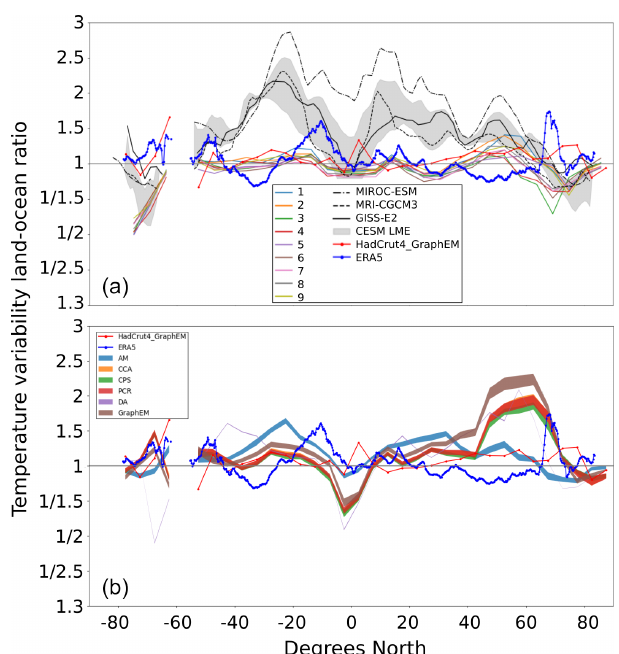
Figure 7. Zonally averaged contrast in land–ocean temperature variability as a function of latitude over the observational period ( > 1850). Atmospheric 2m temperatures over the oceans are used to calculate ocean temperature variability. Results are shown for the nine-member perturbed-parameter i LOVECLIM ensemble (num- bers 1 to 9 in a ), for four different CMIP5 last millennium simu- lations (a) and the results for the six different CFR methods (b) . For comparison, in both panels results are shown for the ERA5 and HadCrut4 observational data sets. Note that the ERA5 data set cov- ers only the period 1979 to 2019. Shading shows the 1 σ range of all CESM and CFR ensemble members in panels (a) and (b) respec- tively. Note that the y -axis scale in the right-hand panel is non-linear with, for instance, 1 / 1 . 5 or 1 / 2, meaning that there is 50% or 100% more variability over the ocean than there is over the continents.